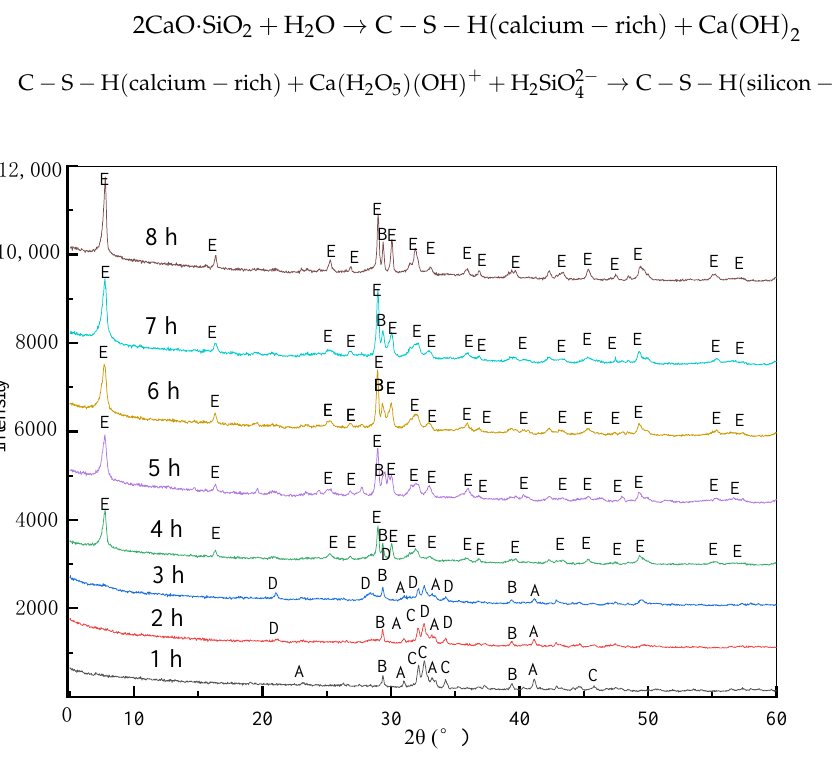
(2) Table 2. EDS analysis and corresponding phase of hydrothermal synthesis at different hydrother- mal synthesis times. Region